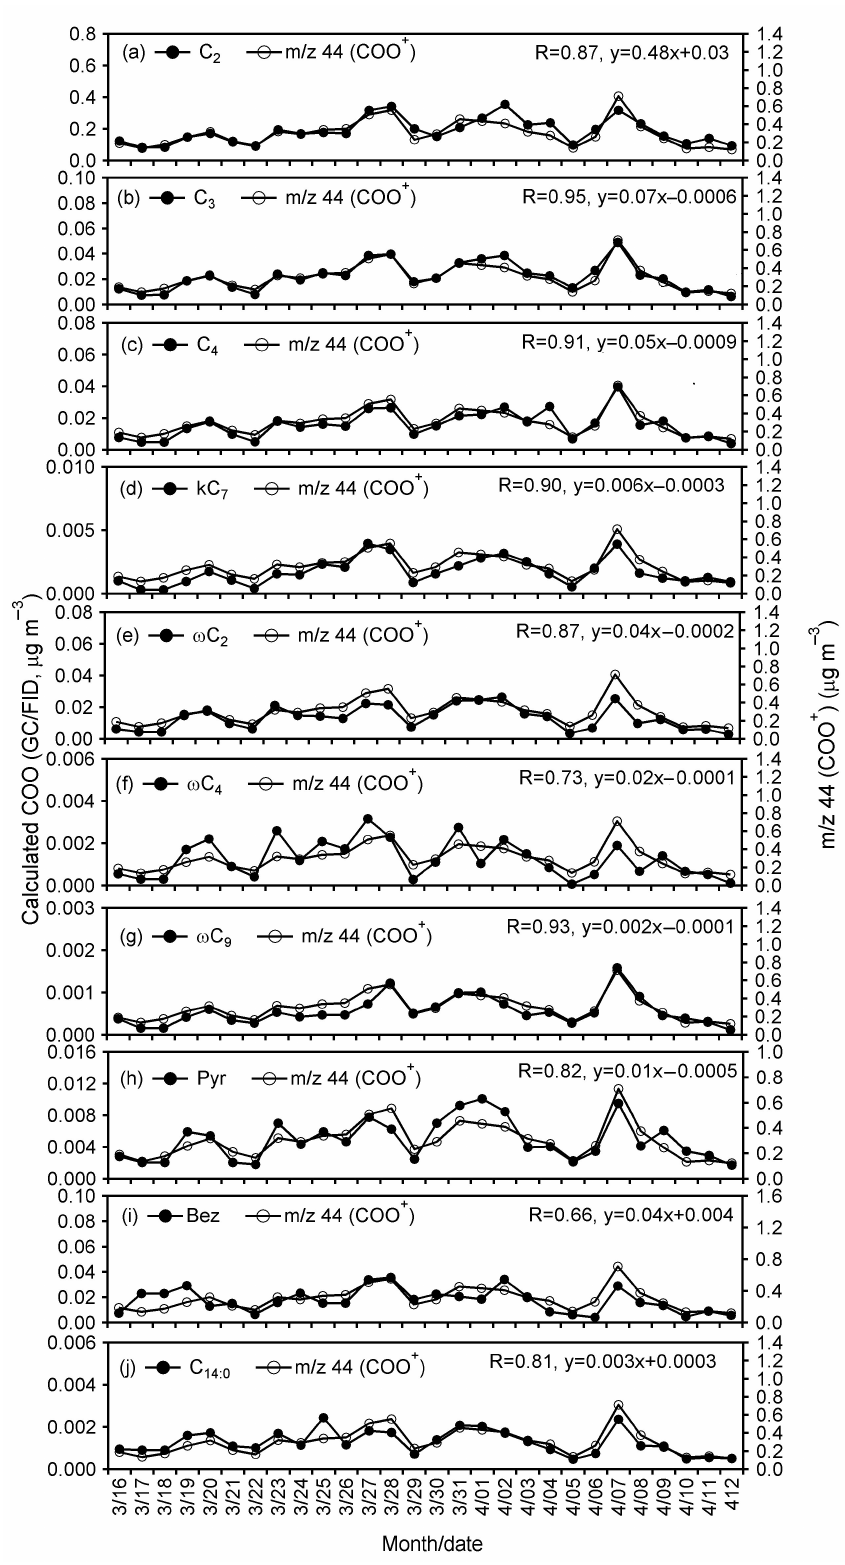
Figure 4. Temporal variations in the COO of selected carboxylic acids obtained by GC/FID and m/z 44 (COO + ) signal obtained by AMS ( a ) oxalic acid (C 2 ), ( b ) malonic acid (C 3 ), ( c ) succinic acid (C 4 ), ( d ) 4 − ketopimelic acid (kC 7 ), ( e ) glyoxylic acid ( ω C 2 ), ( f ) 4 − oxobutanoic acid ( ω C 4 ), ( g ) 9 − oxononanoic acid ( ω C 9 ), ( h ) pyruvic acid (Pyr), ( i ) benzoic acid (Bez), and ( j ) C 14:0 fatty